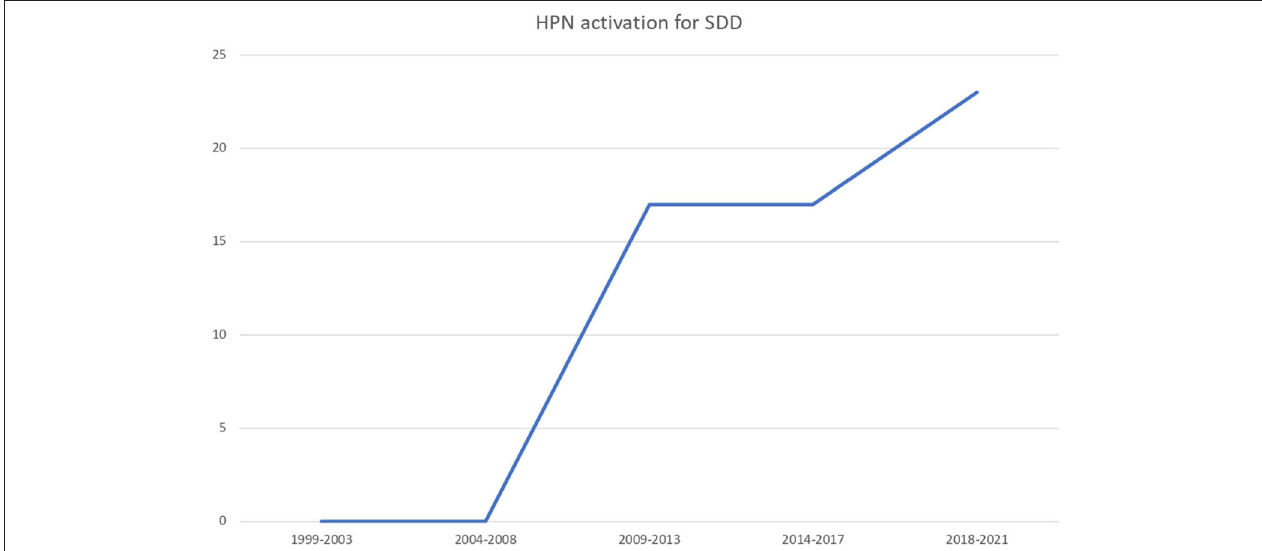
FIGURE 2 | The number of HPN activation because of NPDD along the study period.